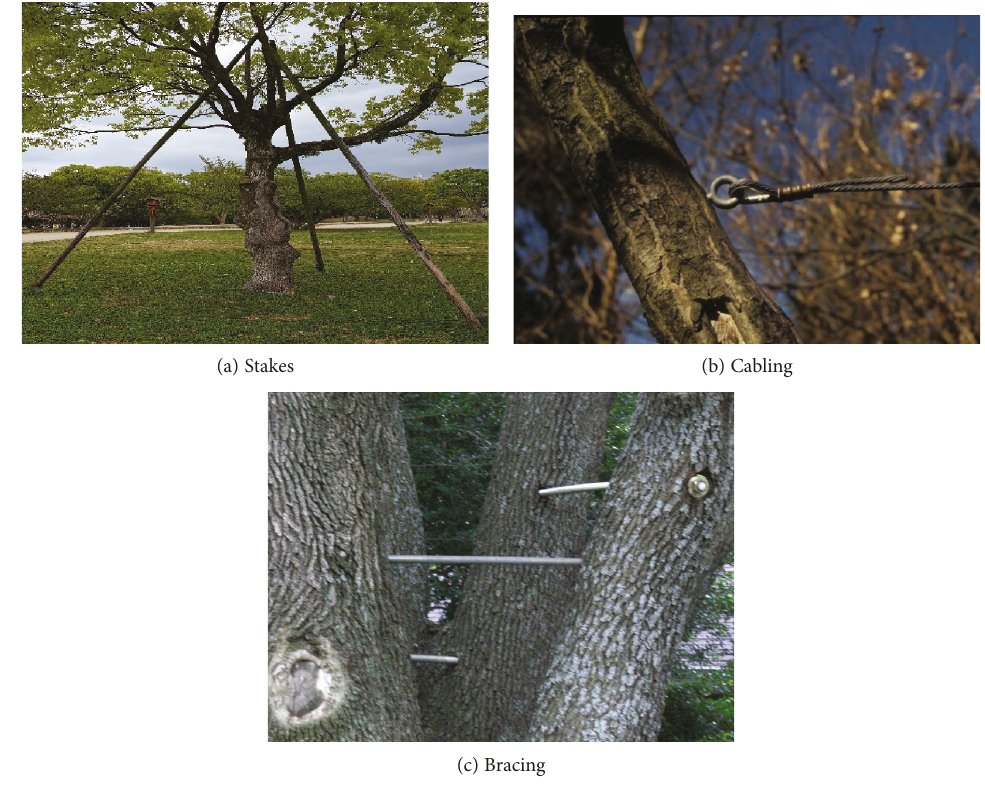
Figure 1: Typical methods of tree reinforcement.